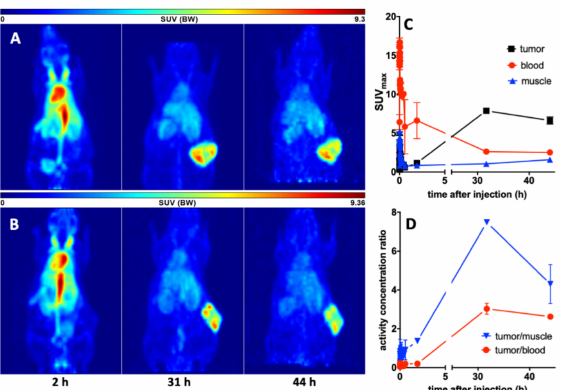
Figure 6. Imaging and kinetics of the 64 Cu-TM distribution in PC3-PSCA/PSMA Luc+ tumor bearing NMRI-Foxn1 nu/nu mice. Maximum intensity projections of the PET studies of ( A ) mouse #1 and ( B ) mouse #2 at 2, 31, and 44 h after injection of the 64 Cu-TM. ( C ) Activity–concentration–time curves in the tumor, blood, and muscle. ( D ) Tumor-to-muscle and tumor-to-blood ratios. Values are means ± SEM of two animals.